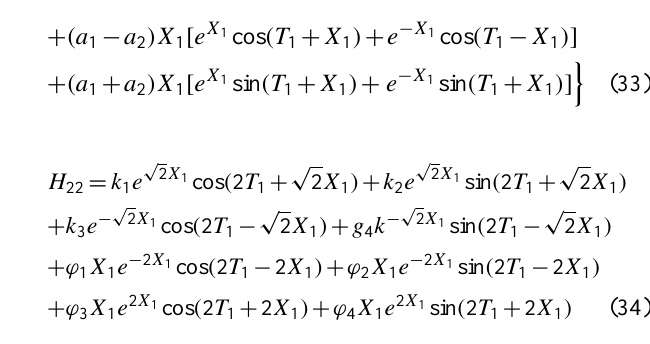
Fig. 3. Comparison between tide-induced water table level ( H ) in Teo et al. (2003) and the present solution for various length ( λ ) of the oceanic island ( ε = 0 . 3, α = 0 . 2, β 1 = β 2 = 45 ◦ ) (a) T = π/ 4; (b) T = π/